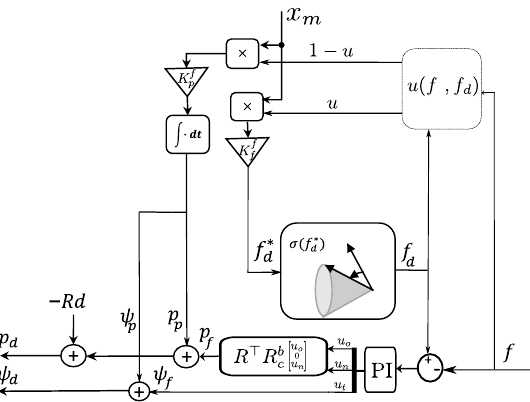
Figure 5. Parallel position/force controller for an aerial manipulator, in the remote side of the teleoperation